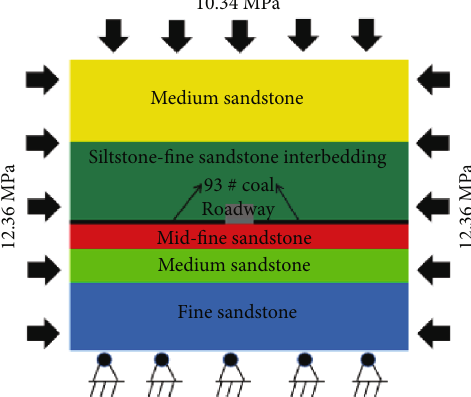
Figure 8: Model schematic and boundary